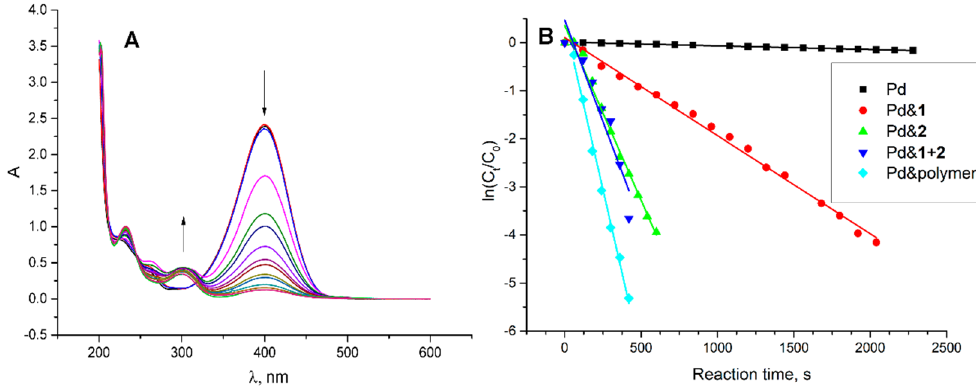
Figure 5. Time-dependent UV/Vis absorption spectra of test reaction mixture in the presence of Pd and polymer ( A ); plots of ln(C t /C 0 ) vs. catalytic reaction time for different Pd-containing catalytic systems ( B ). C(PNP) = 0.1mM, C(NaBH 4 ) = 5 mM, C( 1, 2 , polymer, Pd) = 0.002 mM, H 2 O, 25 ◦